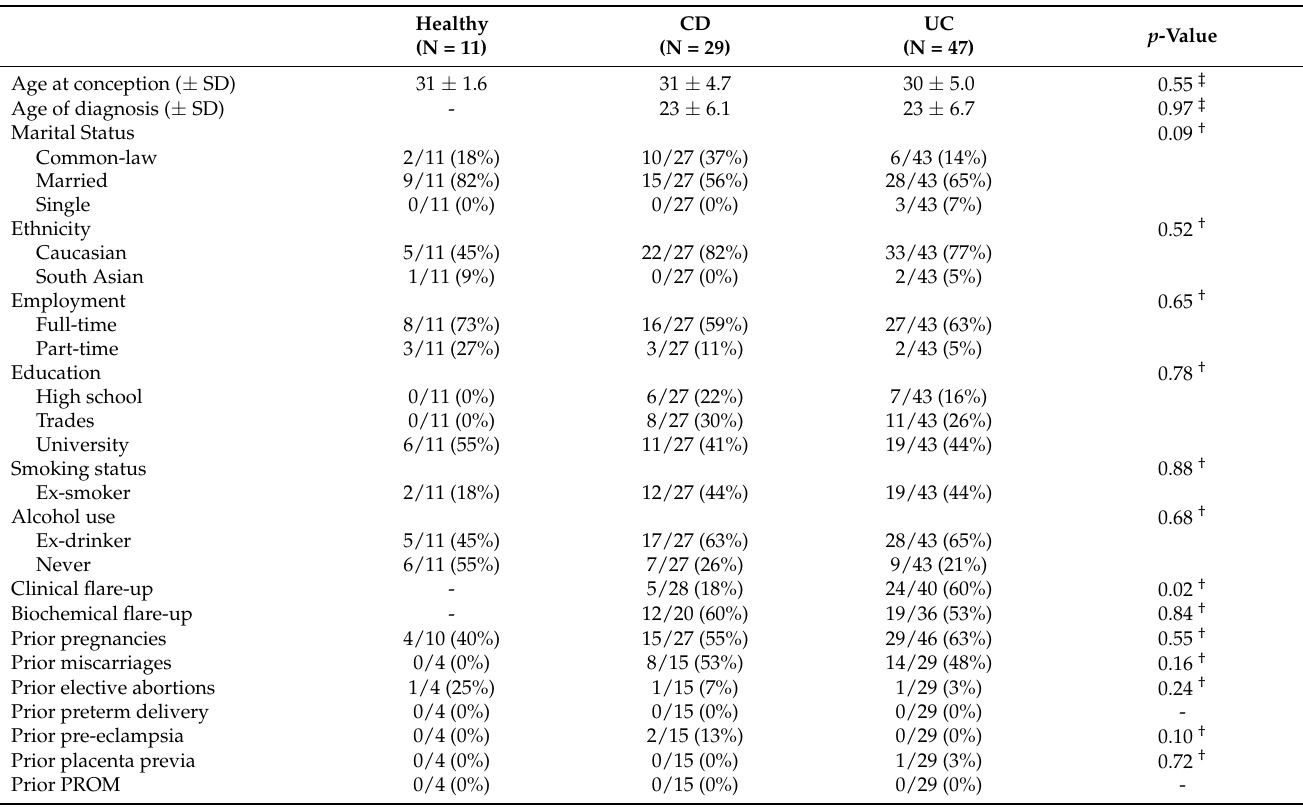
Table 1. Baseline demographics of the study cohort.